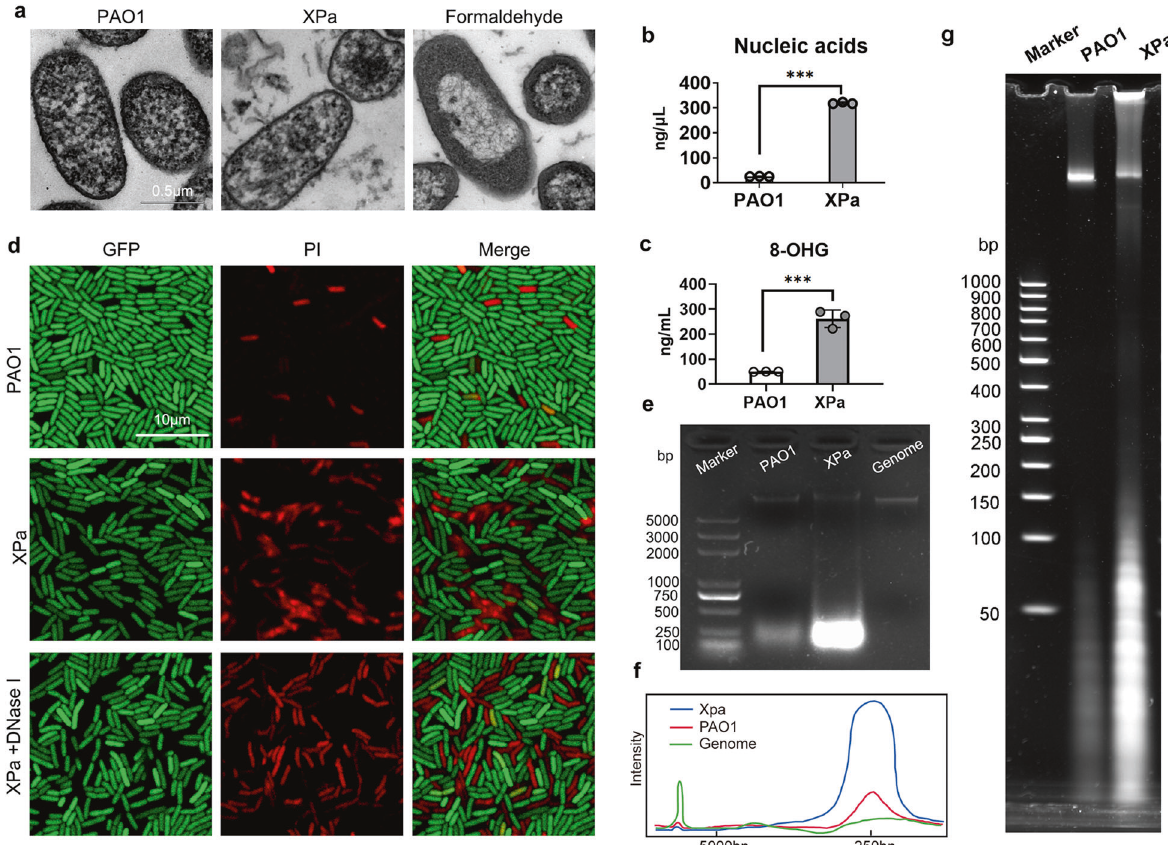
Morphology and biochemical characterization of XPa. a Transmission electron microscopy of PAO1, XPa (X-ray-treated PAO1), and formaldehyde-treated PAO1. Determination of nucleic acid ( b ) and 8-OHG ( c ) concentrations in the supernatant. d PI-stained PAO1-GFP after X-ray irradiation (XPa) and PAO1, and DNase I-treated XPa. e Nucleic acid size distribution in PAO1 and XPa (980 Gy) supernatants and the PAO1 genome were analyzed via agarose gel electrophoresis in the presence of a 2000-bp DNA ladder as a marker. f Molecular weight distribution curves according to e . g The supernatants of the PAO1 and XPa groups were separated on a 4 – 20% polyacrylamide TBE gel (Invitrogen, EC62255BOX), and run in 1× TBE buffer for 30 min. The gel was stained with SYBR Gold Nucleic Acid Gel Stain and detected using an enhanced chemiluminescence system (iBright CL1000, Thermo Fisher). Data were analyzed using an unpaired t -test. *** P <